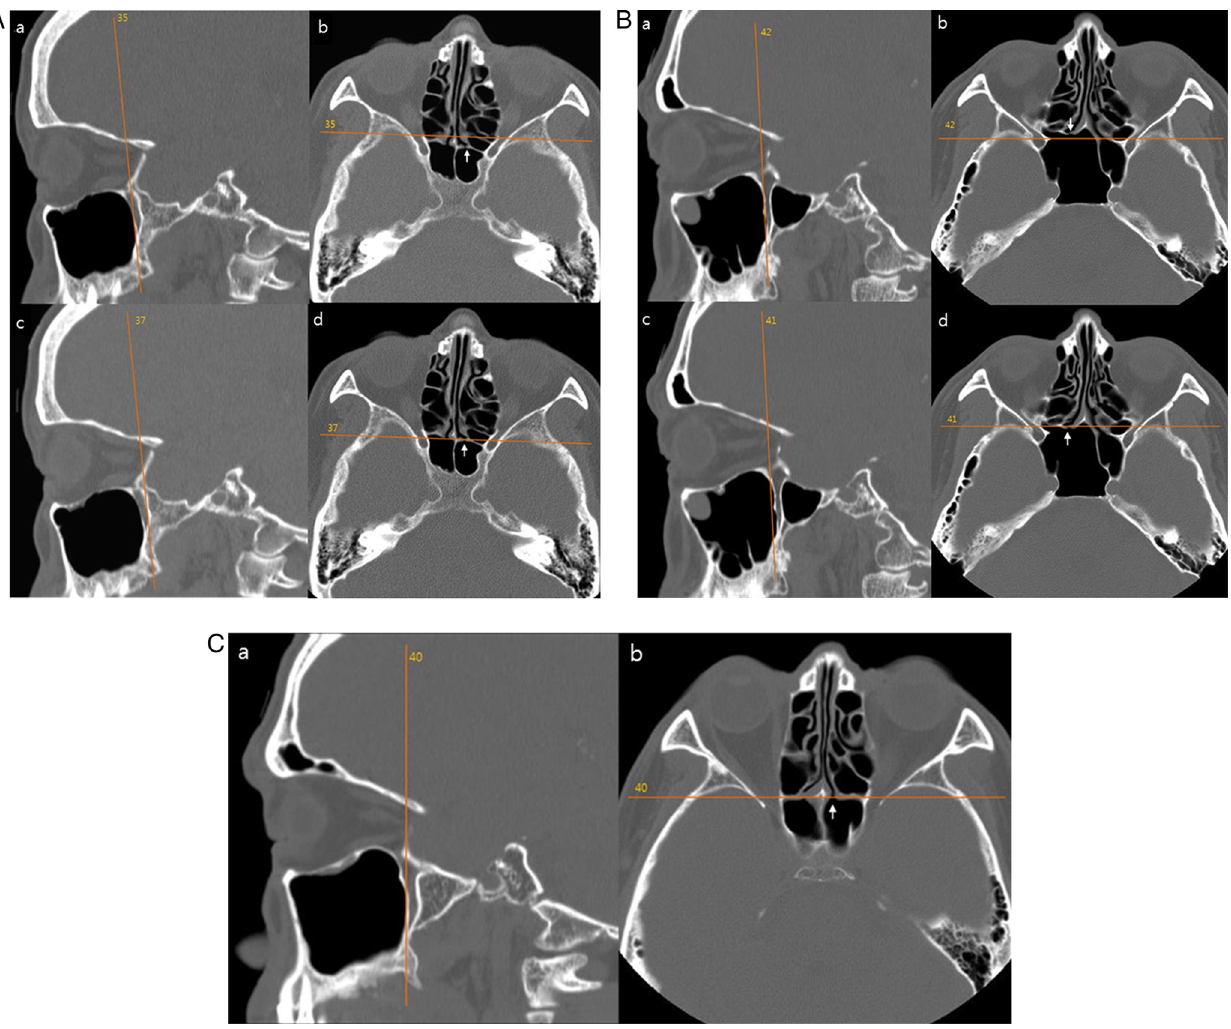
Figure 2 (A) The left sphenoid ostium (arrows in b and d) is 2 slices behind the coronal plane of the posterior wall of the left maxillary sinus (a). (B) The right sphenoid ostium (arrows in b and d) is one slice in front of the coronal plane of the posterior wall of the right maxillary sinus (a). (C) The left sphenoid ostium (b) is in the same coronal plane of the posterior wall of the left maxillary sinus